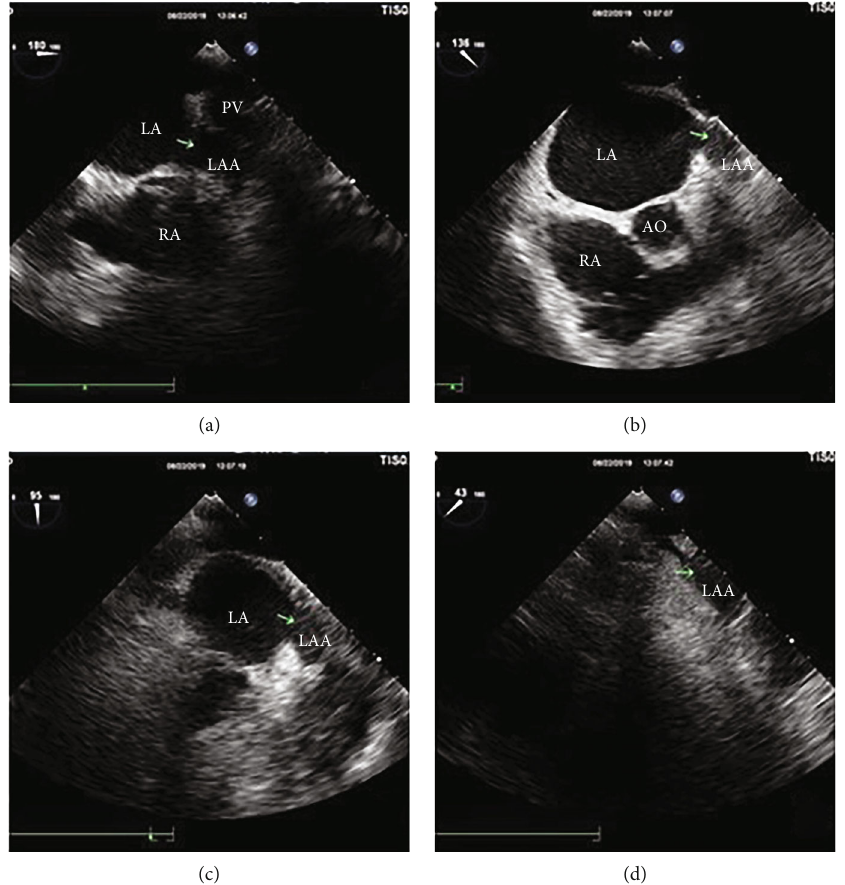
Figure 2: Transesophageal echocardiography (TEE) images before the operation. Transesophageal echocardiography images demonstrated no existing thrombus in the left atrial appendage before the